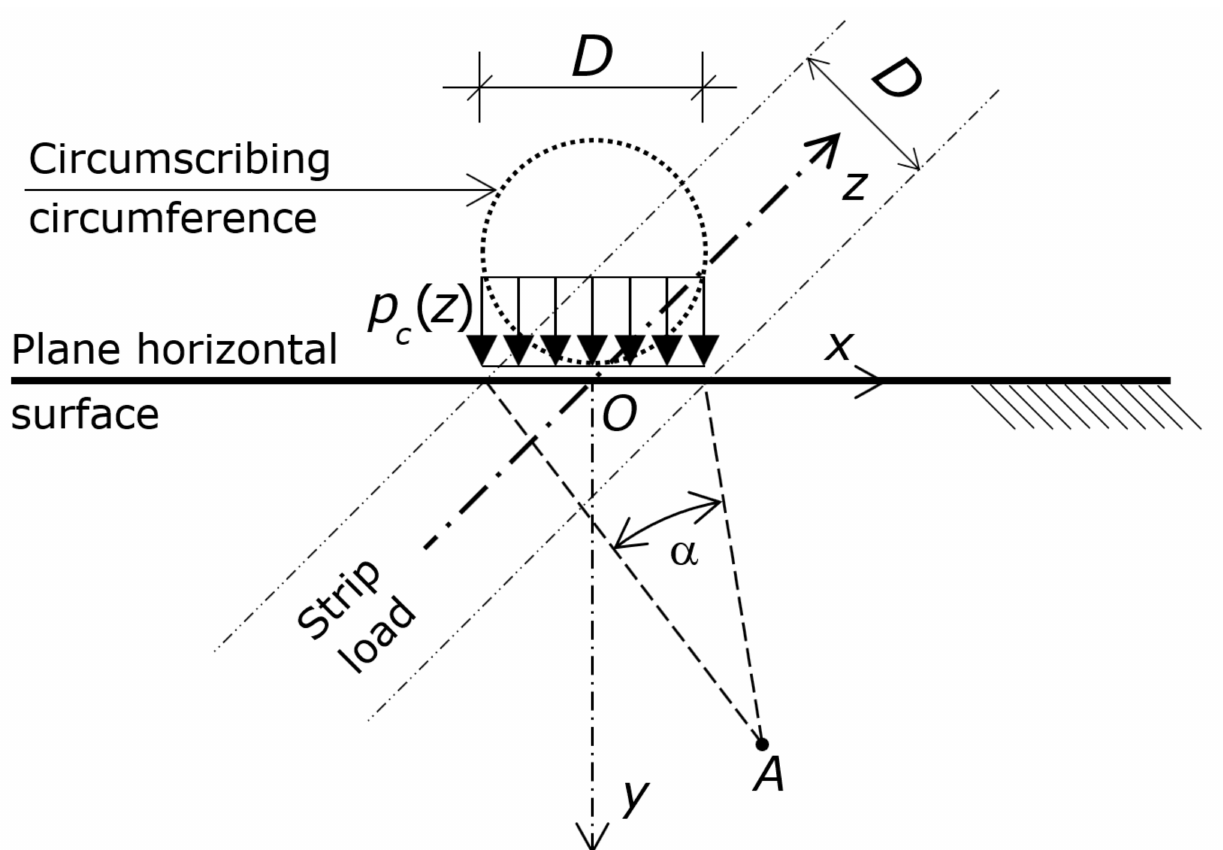
Figure 3. Cartesian coordinate reference system x - y - z , and angular α -coordinate of the generic point A . The origin of the Cartesian coordinate system is on the concrete surface, the x -axis is tangent to the external circle and orthogonal to the shear force V g , the y -axis is along the shear force V g , and the z -axis is parallel to the axis of the circumscribing cylinder. The figure shows the compressive stresses p c , which act on a strip whose width is along the x -axis and is tangent to the circumscribing cylinder. The compressive stresses p c acting at a given z are constant along the width D (i.e., do not vary along the axis x